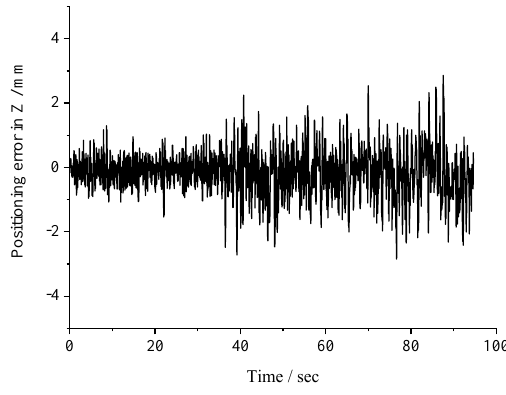
Figure 11. Positioning error of feed platform in Z .